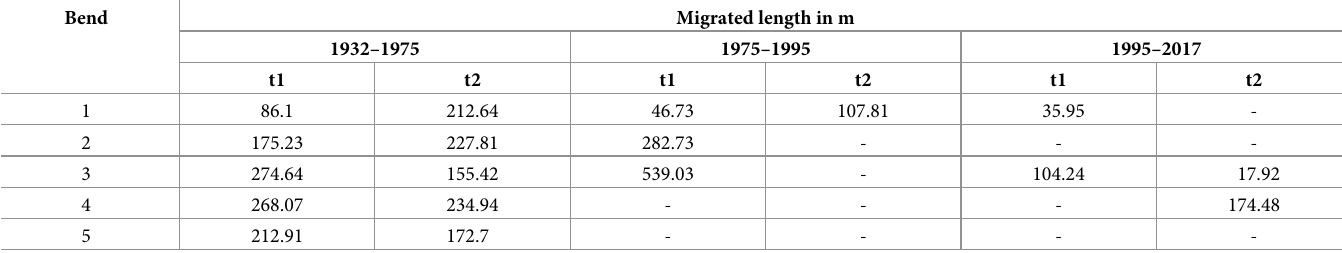
Table 6. Historical migration of the selected meanders. Bend Migrated length in